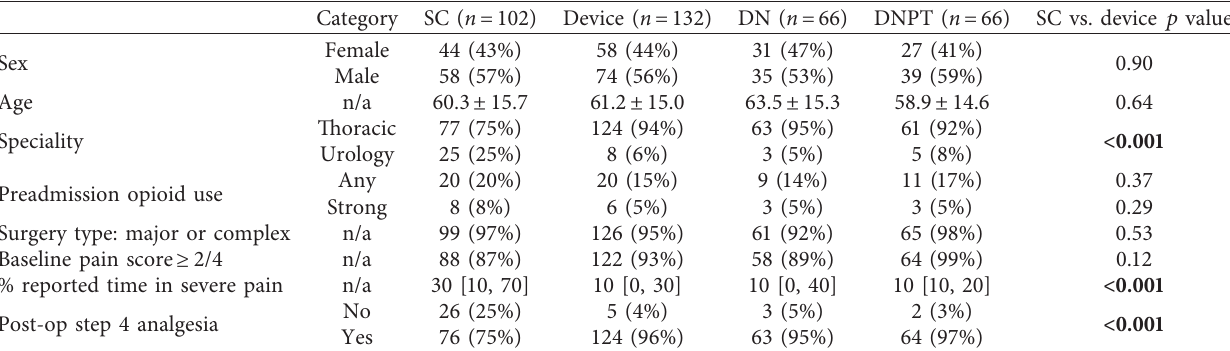
Table 4: Summary statistics are number (percentage), median [interquartile range], or mean ± standard